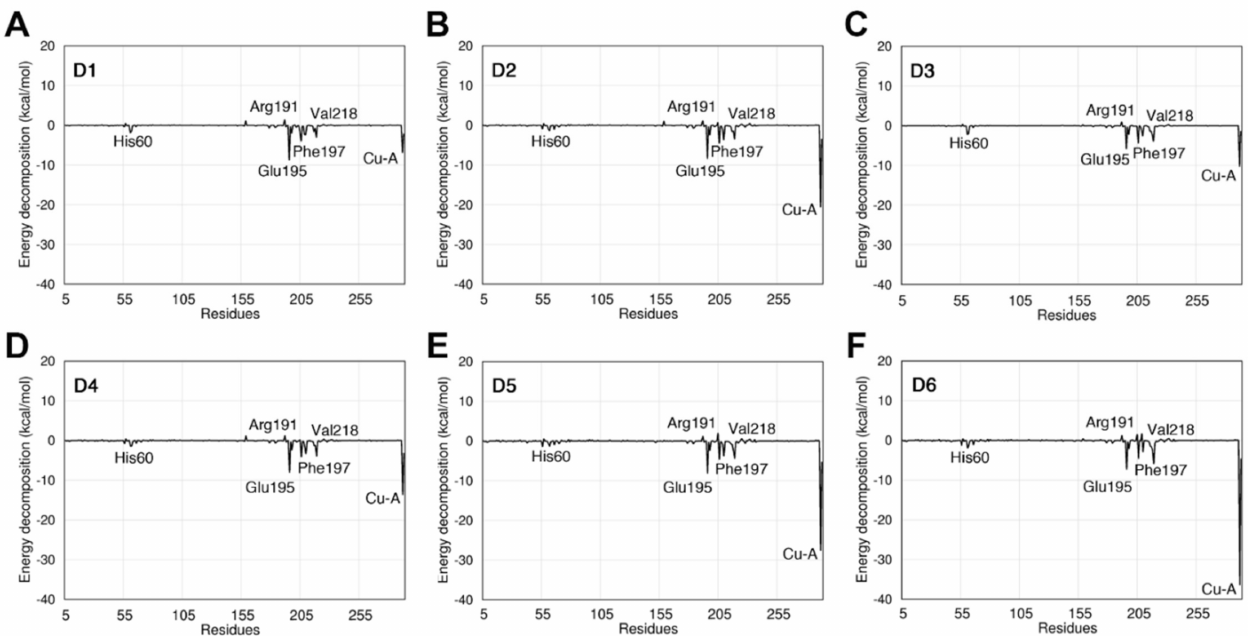
Figure 6. Pairwise energy decomposition analysis of the residues located at the tyrosinase binding pocket complexed with the KA derivatives, ( A ) Derivative D1; ( B ) D2; ( C ) D3; ( D ) D4; ( E ) D5; ( F )